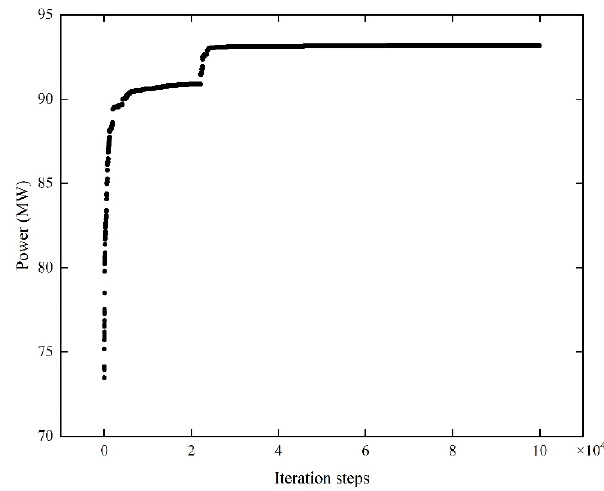
Figure 9. Iteration history of the optimization for 12 six-turbine platforms.